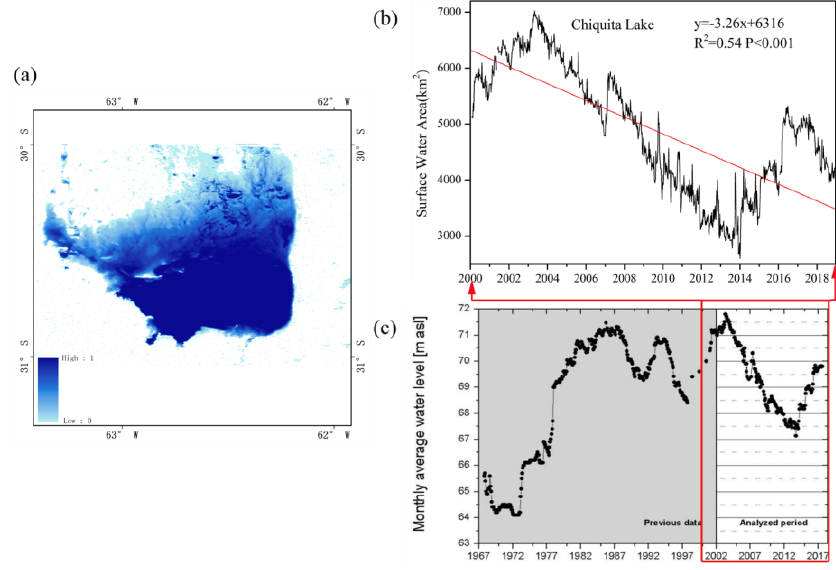
Figure 9. ( a ) Water occurrence and ( b ) water area changes of Chiquita Lake from 2000 to 2018; ( c ) monthly average water level of Chiquita Lake [50].